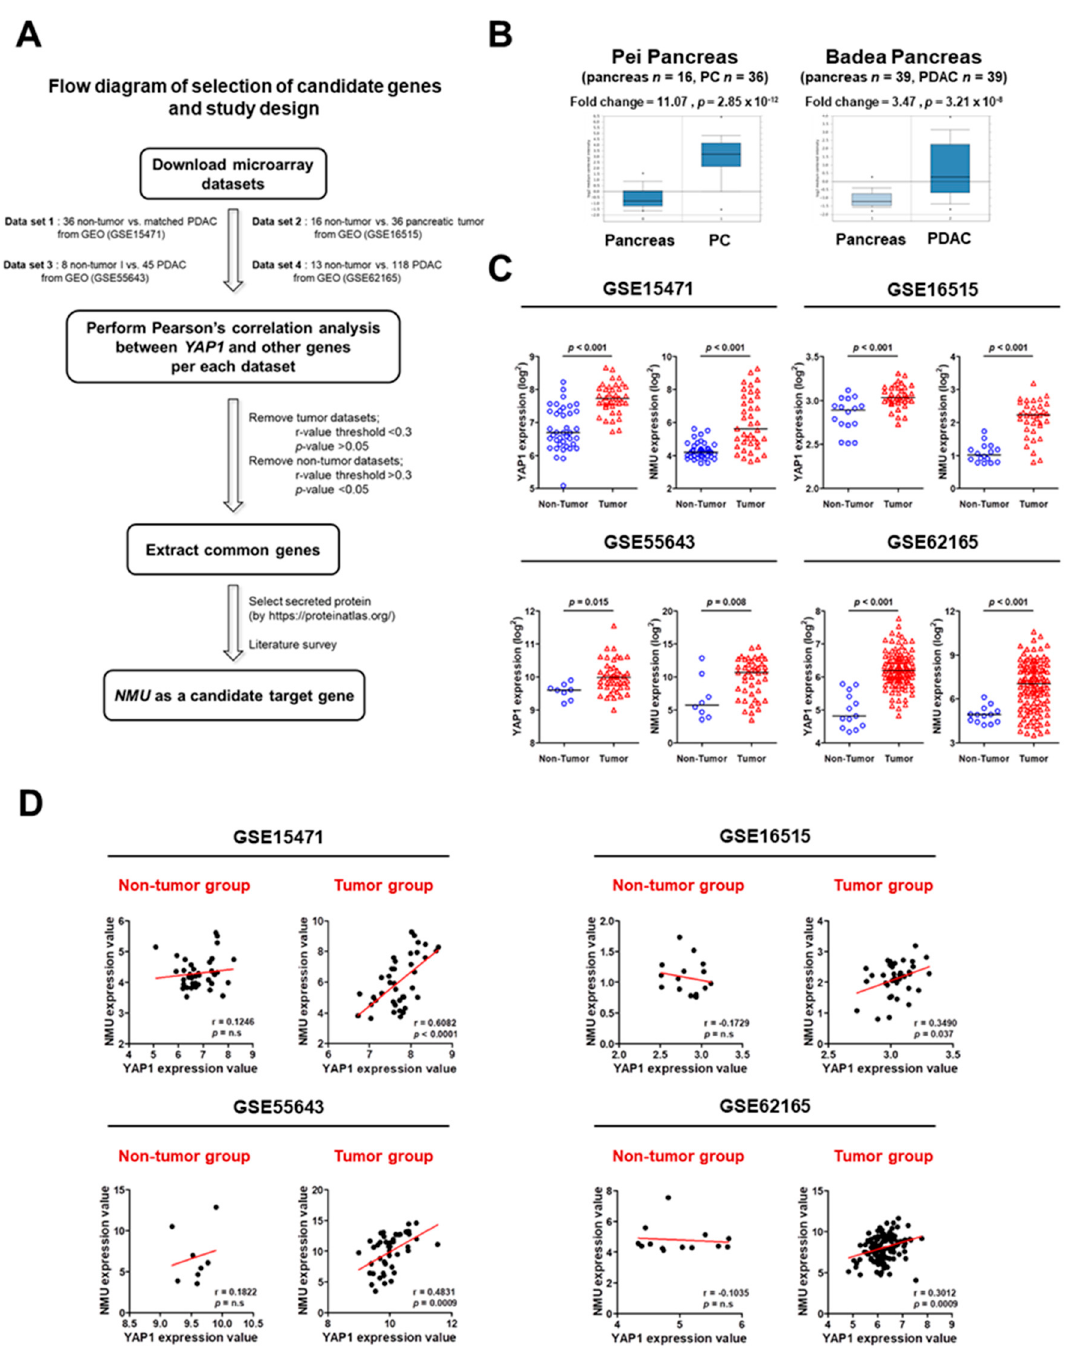
Figure 1. Construction of prediction models and validation in multiple databases. ( A ) Schematic overview of target gene identification. ( B ) Validation of Neuromedin U (NMU) expression in the cohort of Pei and Badea from Oncomine. ( C ) Validation of Yes-associated protein 1 (YAP1) and NMU expression in cohorts from the GEO dataset. ( D ) Pearson’s correlation analysis of YAP1 and NMU in cohorts from the GEO dataset.